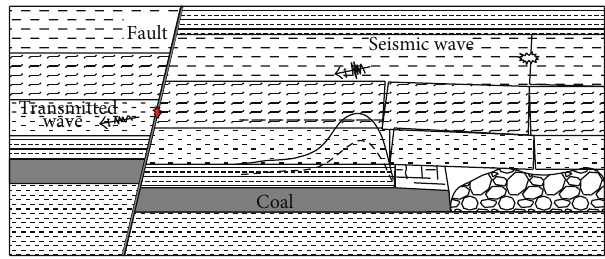
Figure 1: Sketch showing the mechanism associated with